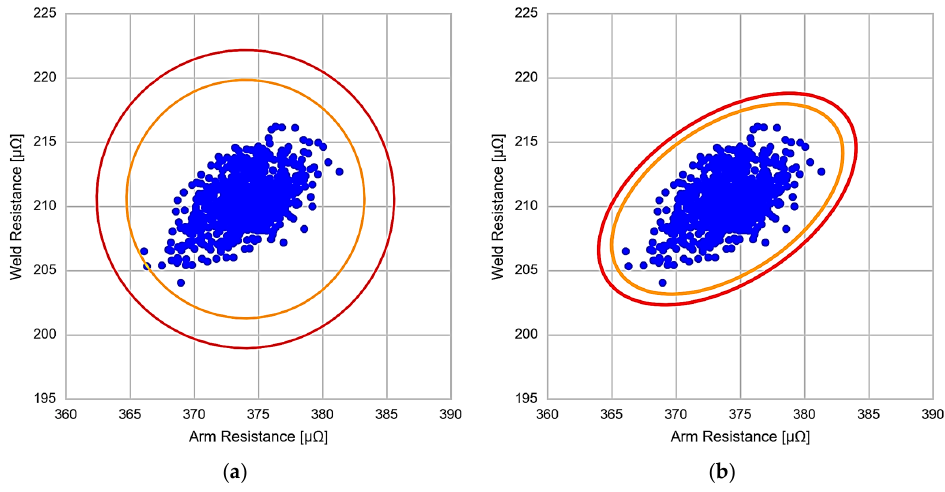
Figure 7. Threshold comparison. ( a ) Euclidean distance. ( b ) Mahalanobis distance.